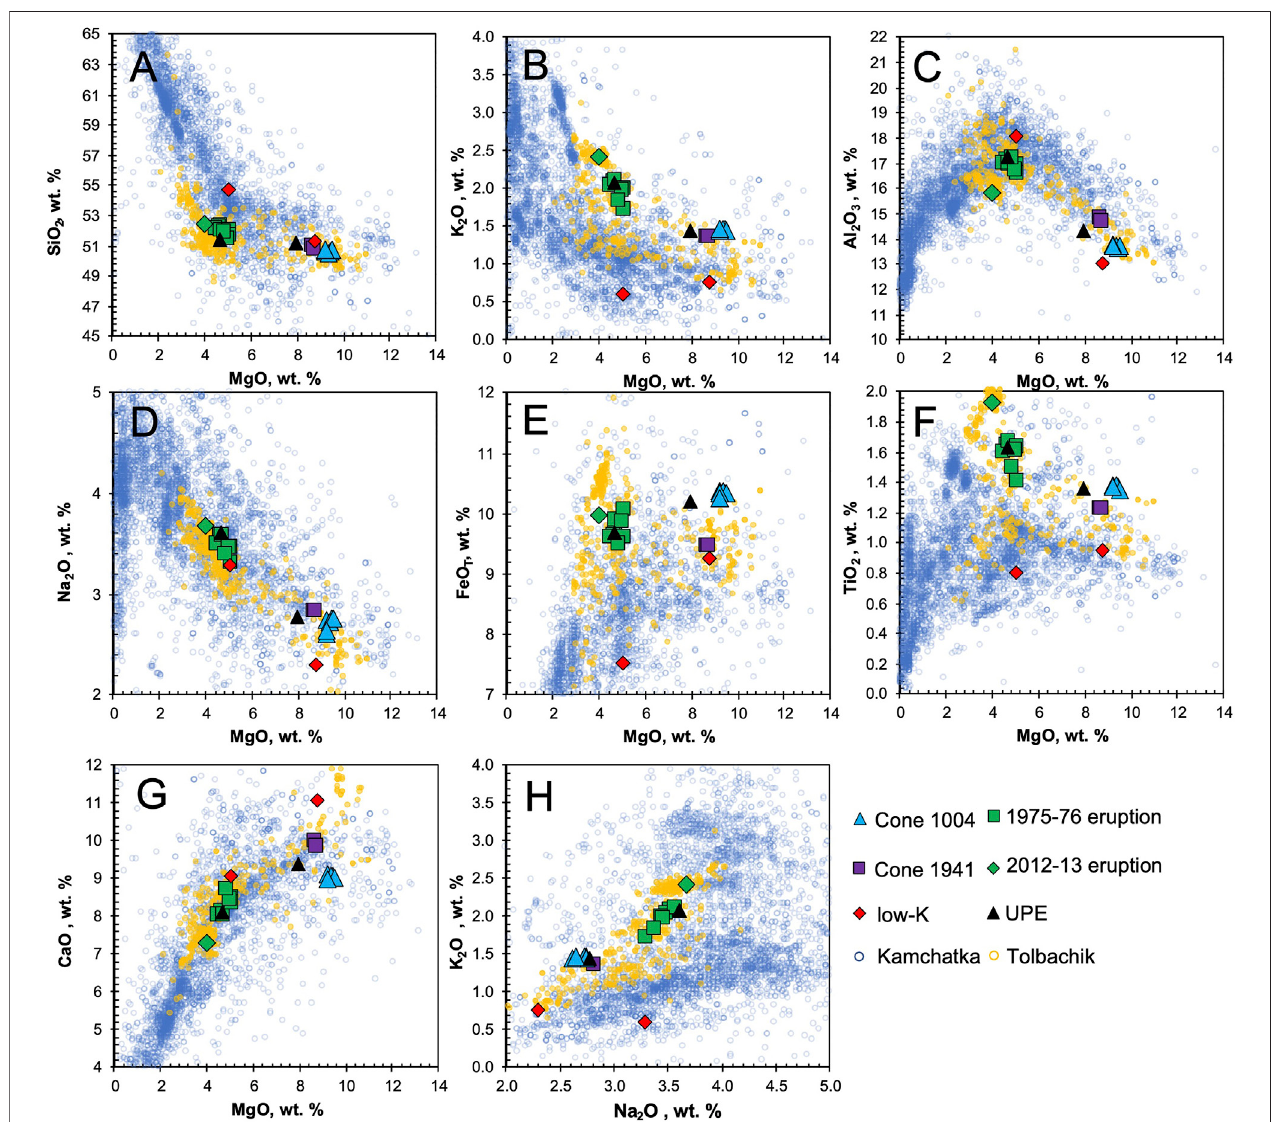
FIGURE 3 | Major element contents in rocks from the Kurile-Kamchatka arc, previously published Tolbachik analyses and new results. Data from GeoRoc (http:// georoc.mpch-mainz.gwdg.de/).